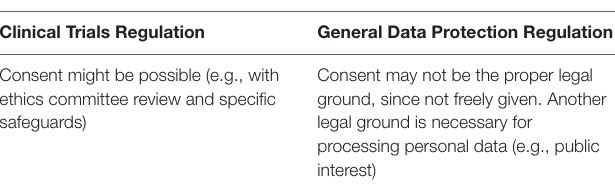
TABLE 1 | Processing health data in imbalanced/dependent cases. Imbalanced/dependent situations (e.g., employer-employee, physician-patient, public authority-citizen) Clinical Trials